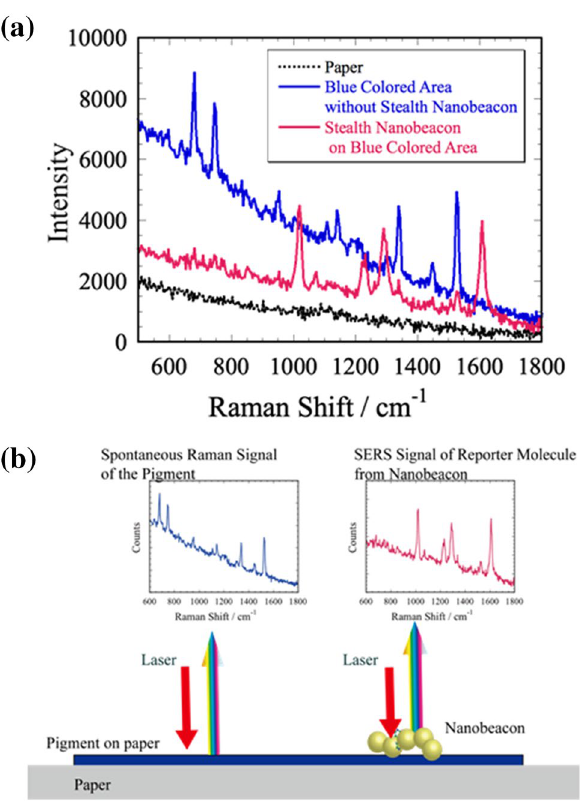
Figure 4. Surface-enhanced Raman spectroscopy measurements on three positions, and the corresponding measurement scheme: ( a ) Spectra of stealth nanobeacons on the blue area of a name card (red solid line), blue area of the name card without the nanobeacons (blue solid line), and paper (black dotted line). ( b ) Scheme of the measurements